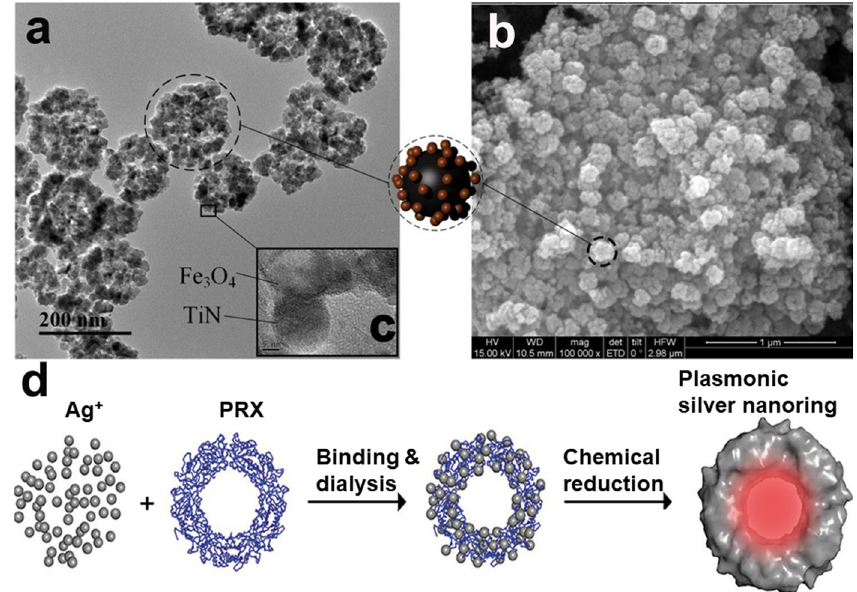
Figure 5: ( a – c ) : ( a ) TEM, ( b ) SEM, and ( c ) HRTEM images of Fe 3 O 4 /TiN NPs ( the dashed circle encircles a nanosphere ) , reproduced with permission [ 126 ] . Copyright 2018, Elsevier. ( d ) Synthesis fl owchart of PRX – Ag NRs, reproduced with permission [ 129 ] . Copyright 2020,